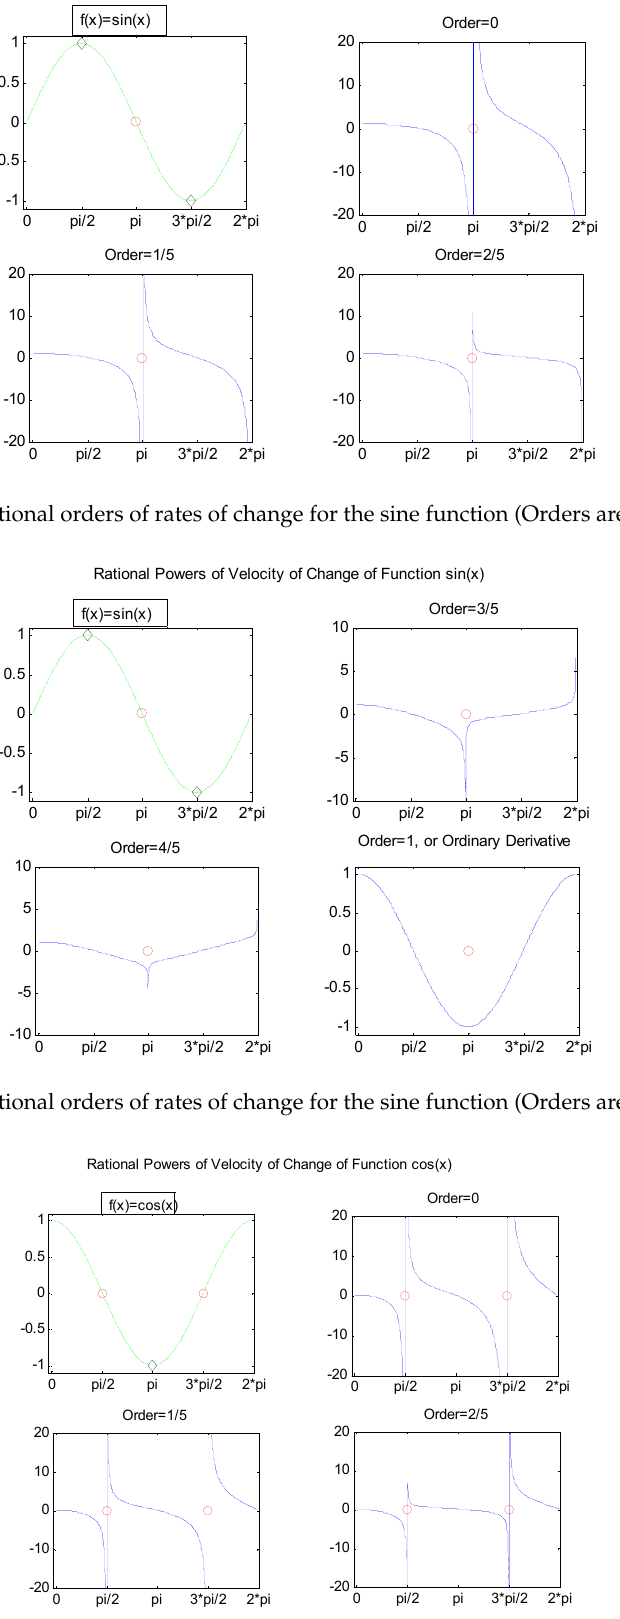
Figure 4. The rational orders of rates of change for the cosine function (Orders are 0, 1/5, 2/5).